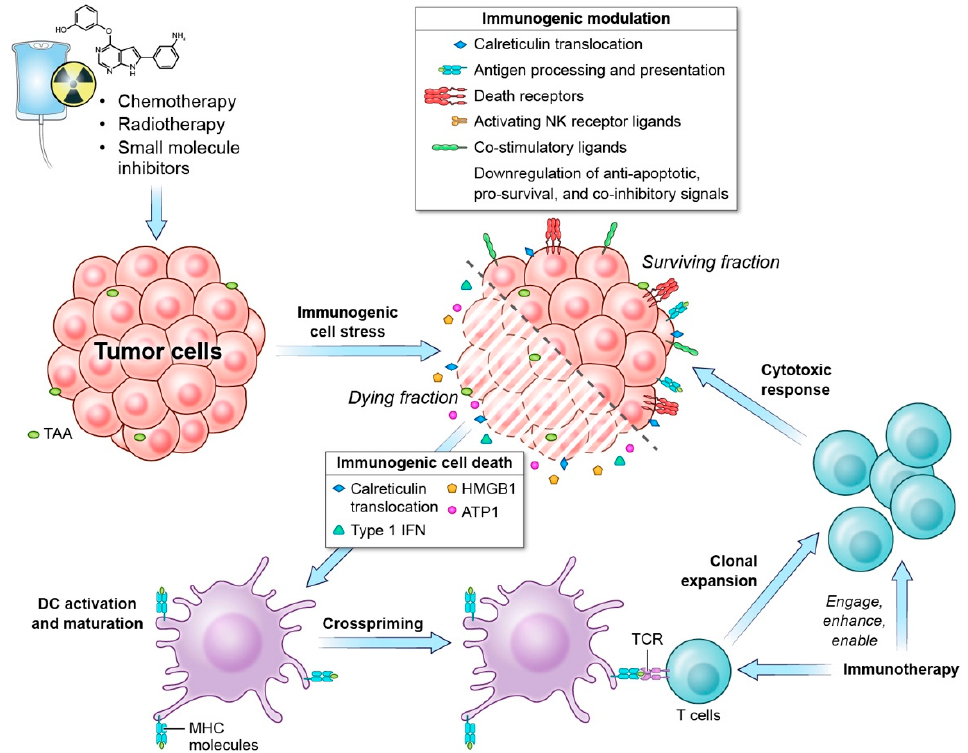
Figure 1. Radiotherapy, chemotherapy, and small-molecule inhibitors induce immunogenic cell stress resulting in immunological responses spanning from immune modulation to immunogenic cell death. Radiotherapy, select chemotherapy, and small-molecule inhibitors can induce immunogenic cell death, which is characterized by the release of DAMPs that promote antigen presenting cells to phagocytose the dying cells, process tumor antigens, and present tumor antigens to T cells. Tumor cells that were not eradicated by radiotherapy, chemotherapy, or small-molecule inhibitors undergo immunogenic modulation wherein the tumor phenotype is altered such that the malignant cells become more sensitized to T cell targeting. Combining radiotherapy, chemotherapy, and small-molecule inhibitors with immunotherapies that can engage, enhance, and enable effector T cells may result in improved immune-mediated eradication of neoplastic cells. DAMP: damage-associated molecular patterns; TAA: tumor ‐ associated antigen; HMGB1: high ‐ mobility group box 1; ATP: